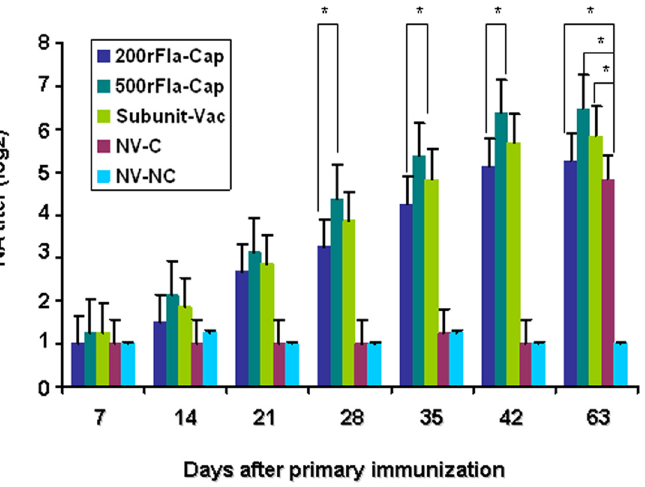
Fig 2. PCV2 neutralizing antibody responses in pigs vaccinated with rFla-Cap protein after vaccination and PCV2 challenge by using an end-point dilution reduction assay. Results indicate mean antibody titers of serum samples for each group ± SD from one of two independent experiments. p < 0.05 ( * ) represents significant difference between 500rFla-Cap and 200rFla-Cap-vaccinated pigs at the indicated times after vaccination, or vaccinated and non-vaccinated pigs after PCV2 challenge (day 63).